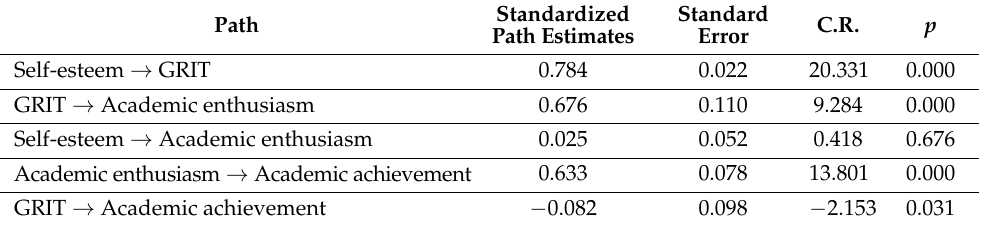
Figure 4. Full mediation model. Table 4. The path estimates and the effect decompositions of the research model.